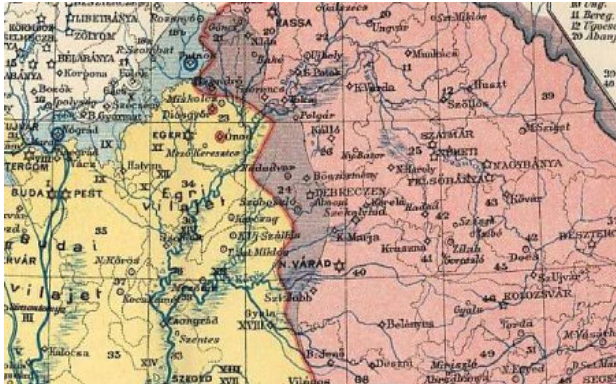
Figure 1. Position of Debrecen in 1606 during Turkish occupation (yellow: occupied and controlled; pink: Transylvanian Principality; darkened overlapping: subservient territory) (Acsády, ?)